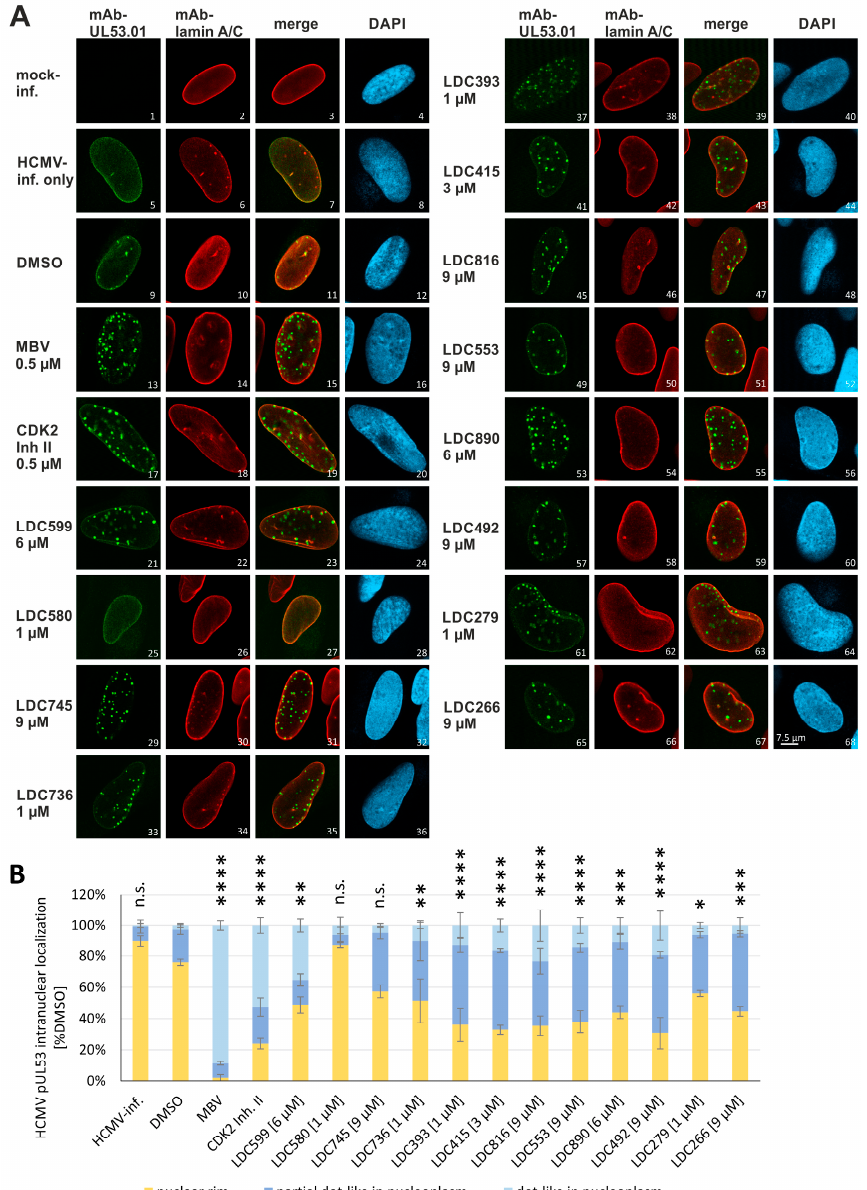
Figure 4. Impact of those warhead compounds possessing antiviral activity on the localization of HCMV pUL53. ( A ) HFFs were infected with HCMV AD169 (MOI 0.1) and immediately treated with warhead compounds. Compounds were applied, as based on their individual EC 50 values, at concentrations exerting partial-grade antiviral activity (see indicated), and the determination was performed in biological triplicates. At 5 d p.i., cells were fixed, used for IF staining with the indicated antibodies and analyzed for intranuclear localization by confocal imaging. DAPI counterstaining indicated the nuclei morphology of the respective cells. Additional single channel images in grayscale, allowing easier comparison of signal patterns, are presented in Figure S1. For raw data, see https://doi.org/10.5281/zenodo.7794233; accessed on 3 April 2023 ( B ) Quantitation of this IF analysis was achieved by counting 50 cells per biological triplicate. Three patterns of pUL53 localization were distinguished, i.e., normal nuclear rim (yellow), partial dot-like intranucleoplasmic aggregation (dark blue) and predominant dot-like aggregation (light blue). Mean values ± SDs are given. Statistical analysis was performed using ordinary one-way ANOVA and post hoc Tukey testing on combined dot-like pUL53 localization values of DMSO in relation to the analyzed ibrutinib concentrations and MBV; * p ≤ 0.05, ** p ≤ 0.01, *** p ≤ 0.001, **** p ≤ 0.0001; n.s., not